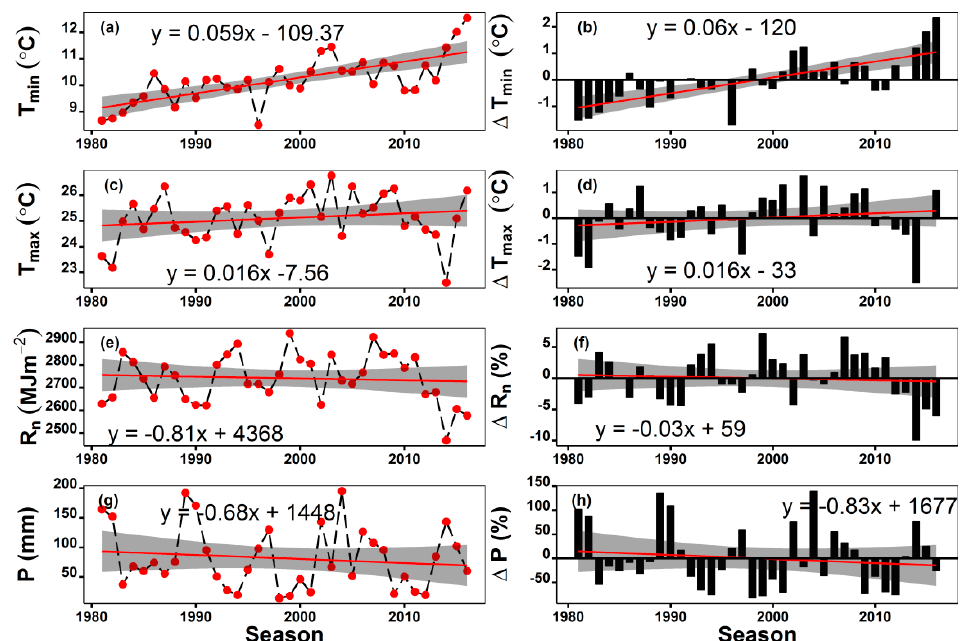
Figure 3. Trends of wheat seasonal average ( a ) minimum temperature (T min ), ( c ) maximum temperature (T max ); and seasonal cumulative ( e ) solar radiation (R n ) and ( g ) rainfall (P) during 1980–2017 (left-hand panel). The right-hand panel (Figure 3 b , d , f , h ) shows the deviations of T min , T max , R n and P from their respective long-term (1980–2017) averaged values during each wheat season. Red lines in Figure 3 a – h show the trends of the climate variables and the grey region represents the 95% confidence interval.